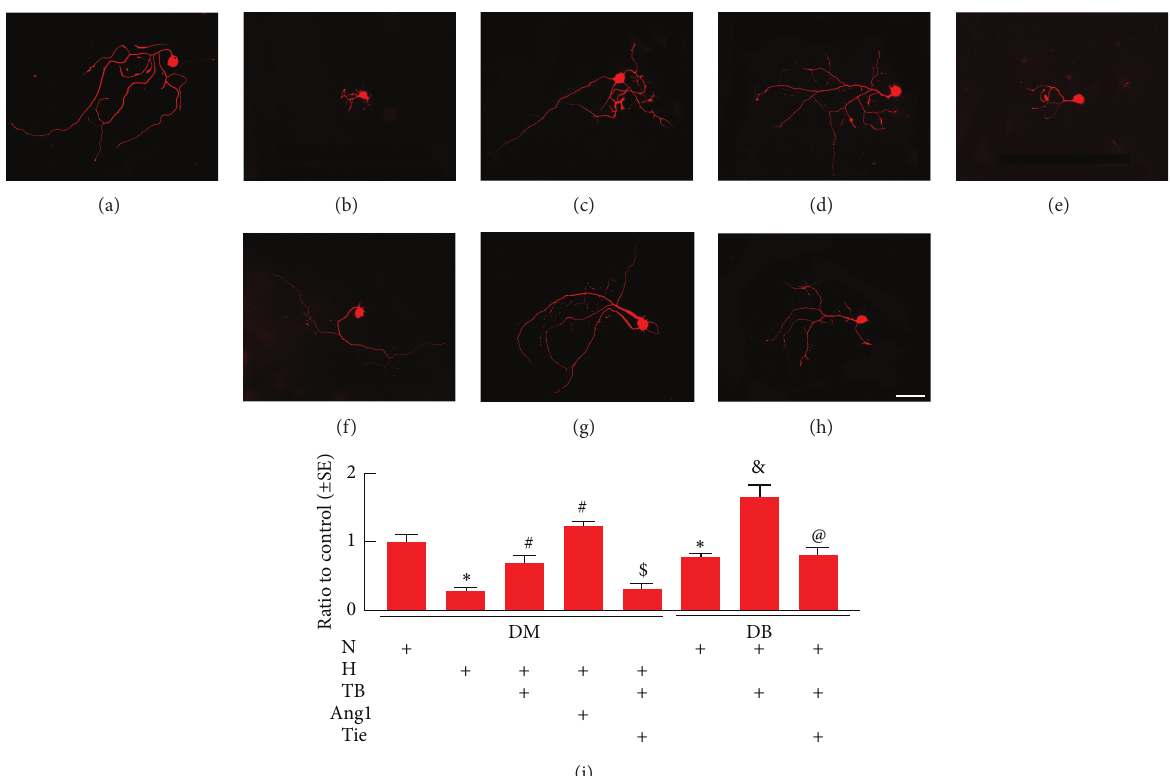
Figure 4: Effect of T 𝛽 4 on DRG neurons neurite outgrowth in vitro. Panels (a) to (e) show NF-H immunoreactive nondiabetic DRG neuron cultured in normal glucose (N, (a)), high glucose (H, (b)), high glucose with T 𝛽 4 (+TB, (c)), high glucose with Ang1 (+Ang, 100ng/mL, (d)), and T 𝛽 4 with antibody against Tie2 (+Tie, 5 𝜇 g/mL, (e)). Panels (f) to (h) show NF-H immunoreactive diabetic DRG neuron cultured in normal glucose (f), normal glucose with T 𝛽 4 (g), and T 𝛽 4 with antibody against Tie2 (h). Panel (i) shows quantitative data of neurite outgrowth. Bar in 𝐻 = 50 𝜇 m. ∗ 𝑃 < 0.05 versus the nondiabetic DRG neurons (DM) in normal glucose and # 𝑃 < 0.05 versus nondiabetic DRG neurons in the high glucose. $ 𝑃 < 0.05 versus nondiabetic DRG neurons treated with T 𝛽 4 in high glucose, & 𝑃 < 0.05 versus diabetic